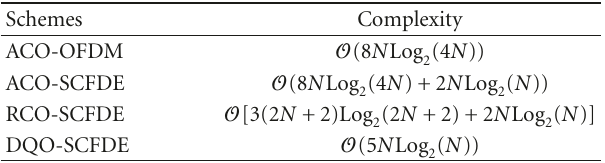
Table 1: Computational complexity comparison of the four modulation